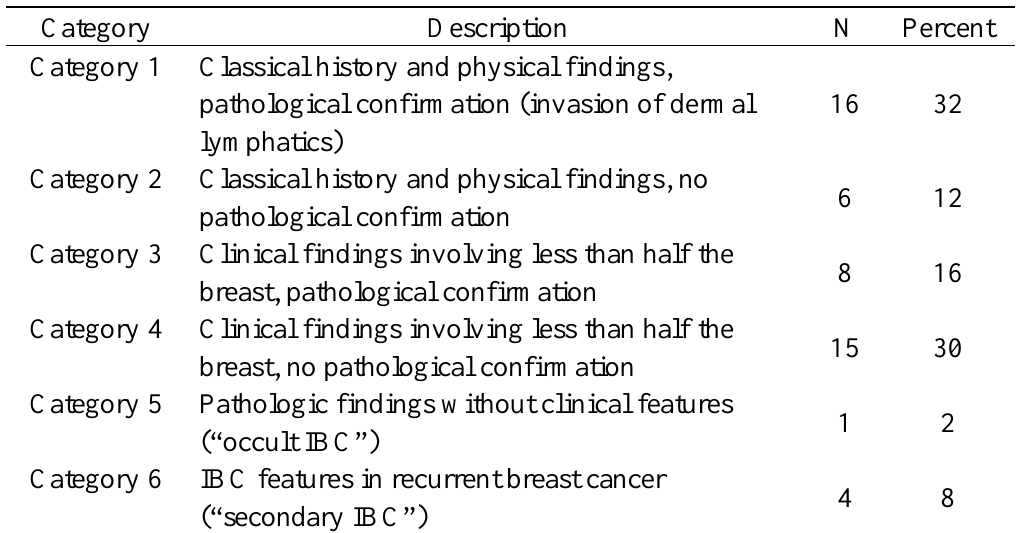
Figure 1. Clinical photo of IBC patient. Inflammatory breast cancer of the right breast characterized by marked edema and swelling, erythema and dimpling ("peau